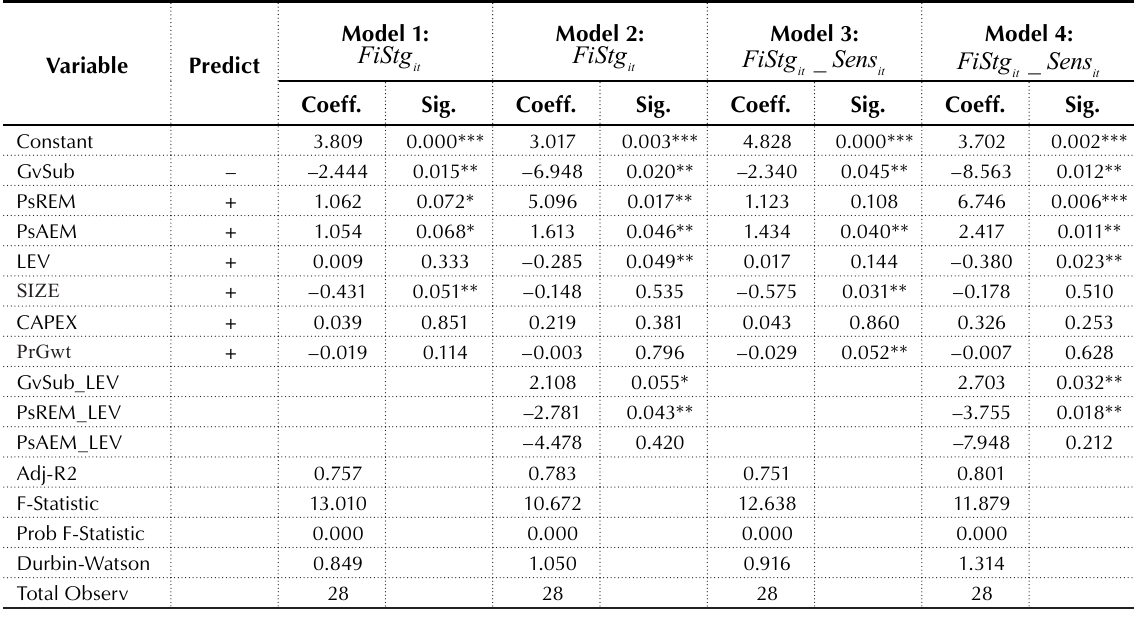
Table 4. Results of regression analysis (hypotheses